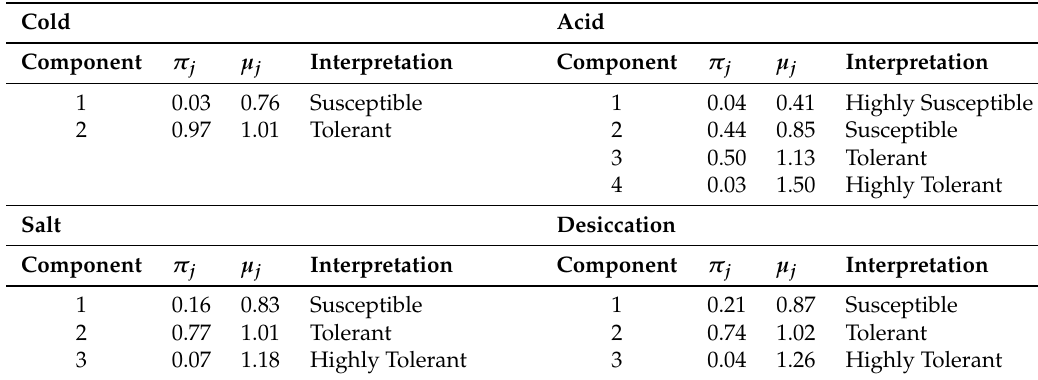
Table 2. Probabilities, averages of categories and interpretations of the L. monocytogenes stress response